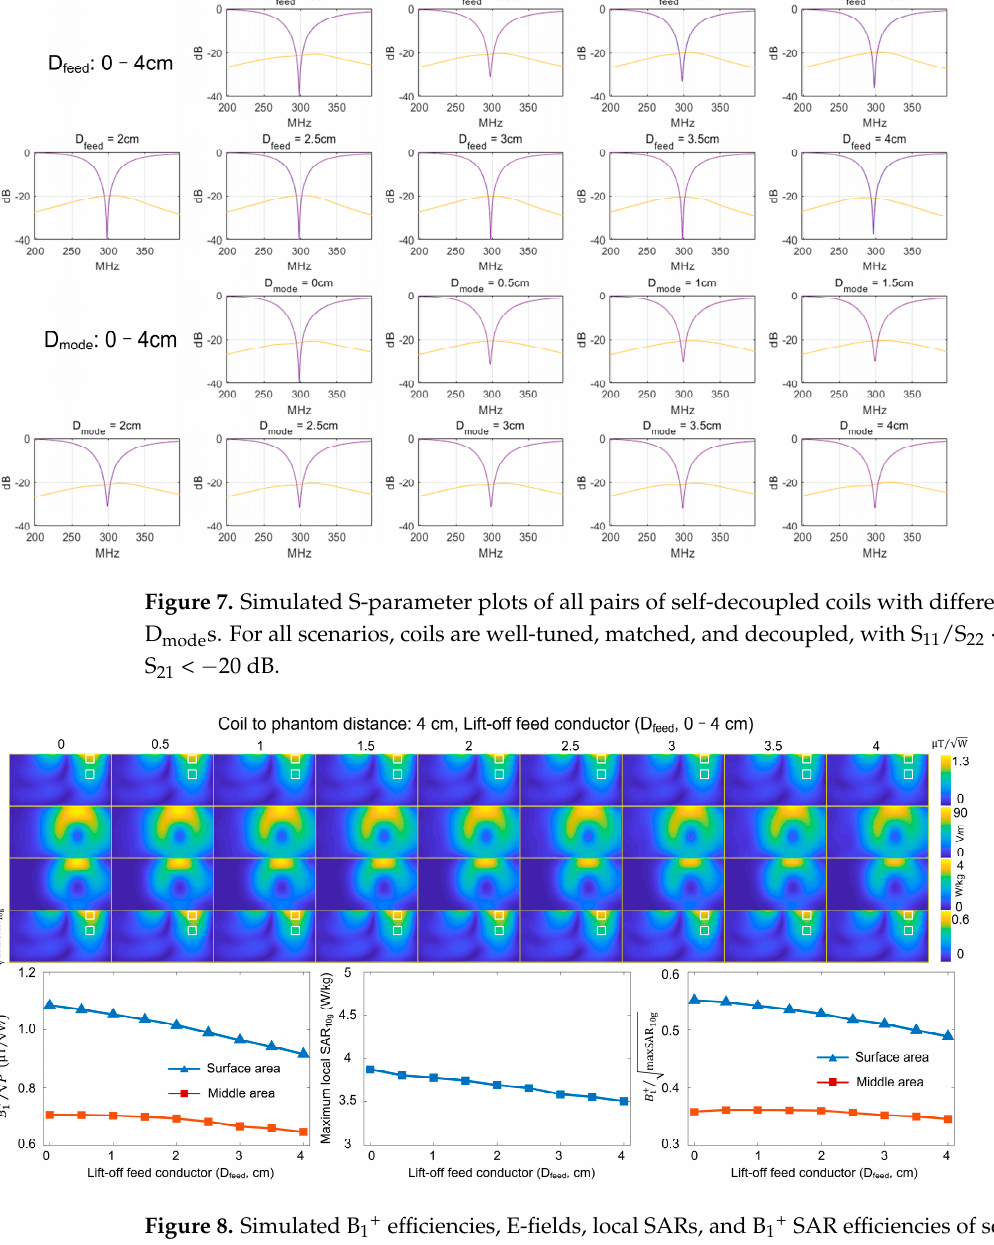
Figure 8. Simulated B 1+ efficiencies, E-fields, local SARs, and B 1+ SAR efficiencies of self-decoupled coils with different lift-off distances of the feed conductor (D feed ) and coil-to-phantom distance equal to 4 cm.